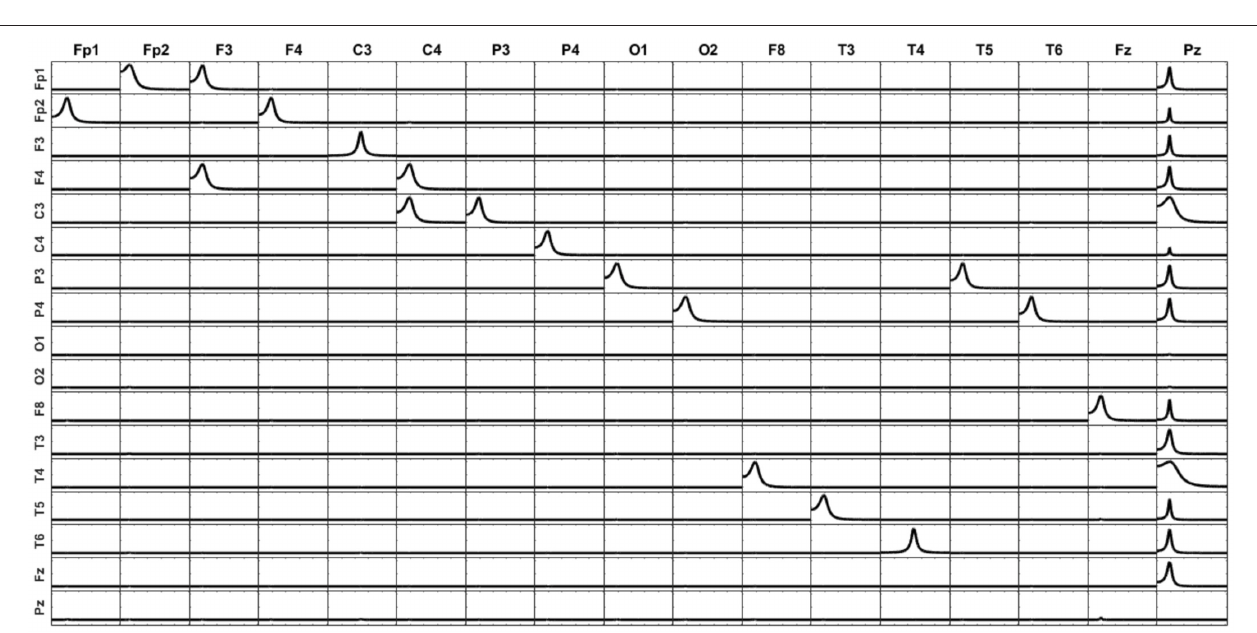
source directions, to increase the number of independent local sources in the brain, the lead field is projected to the normal direction of each voxel. Then, we divide the external side of the surface into 18 disjoint regions, 9 regions in each hemisphere, as it is shown in Figure 11